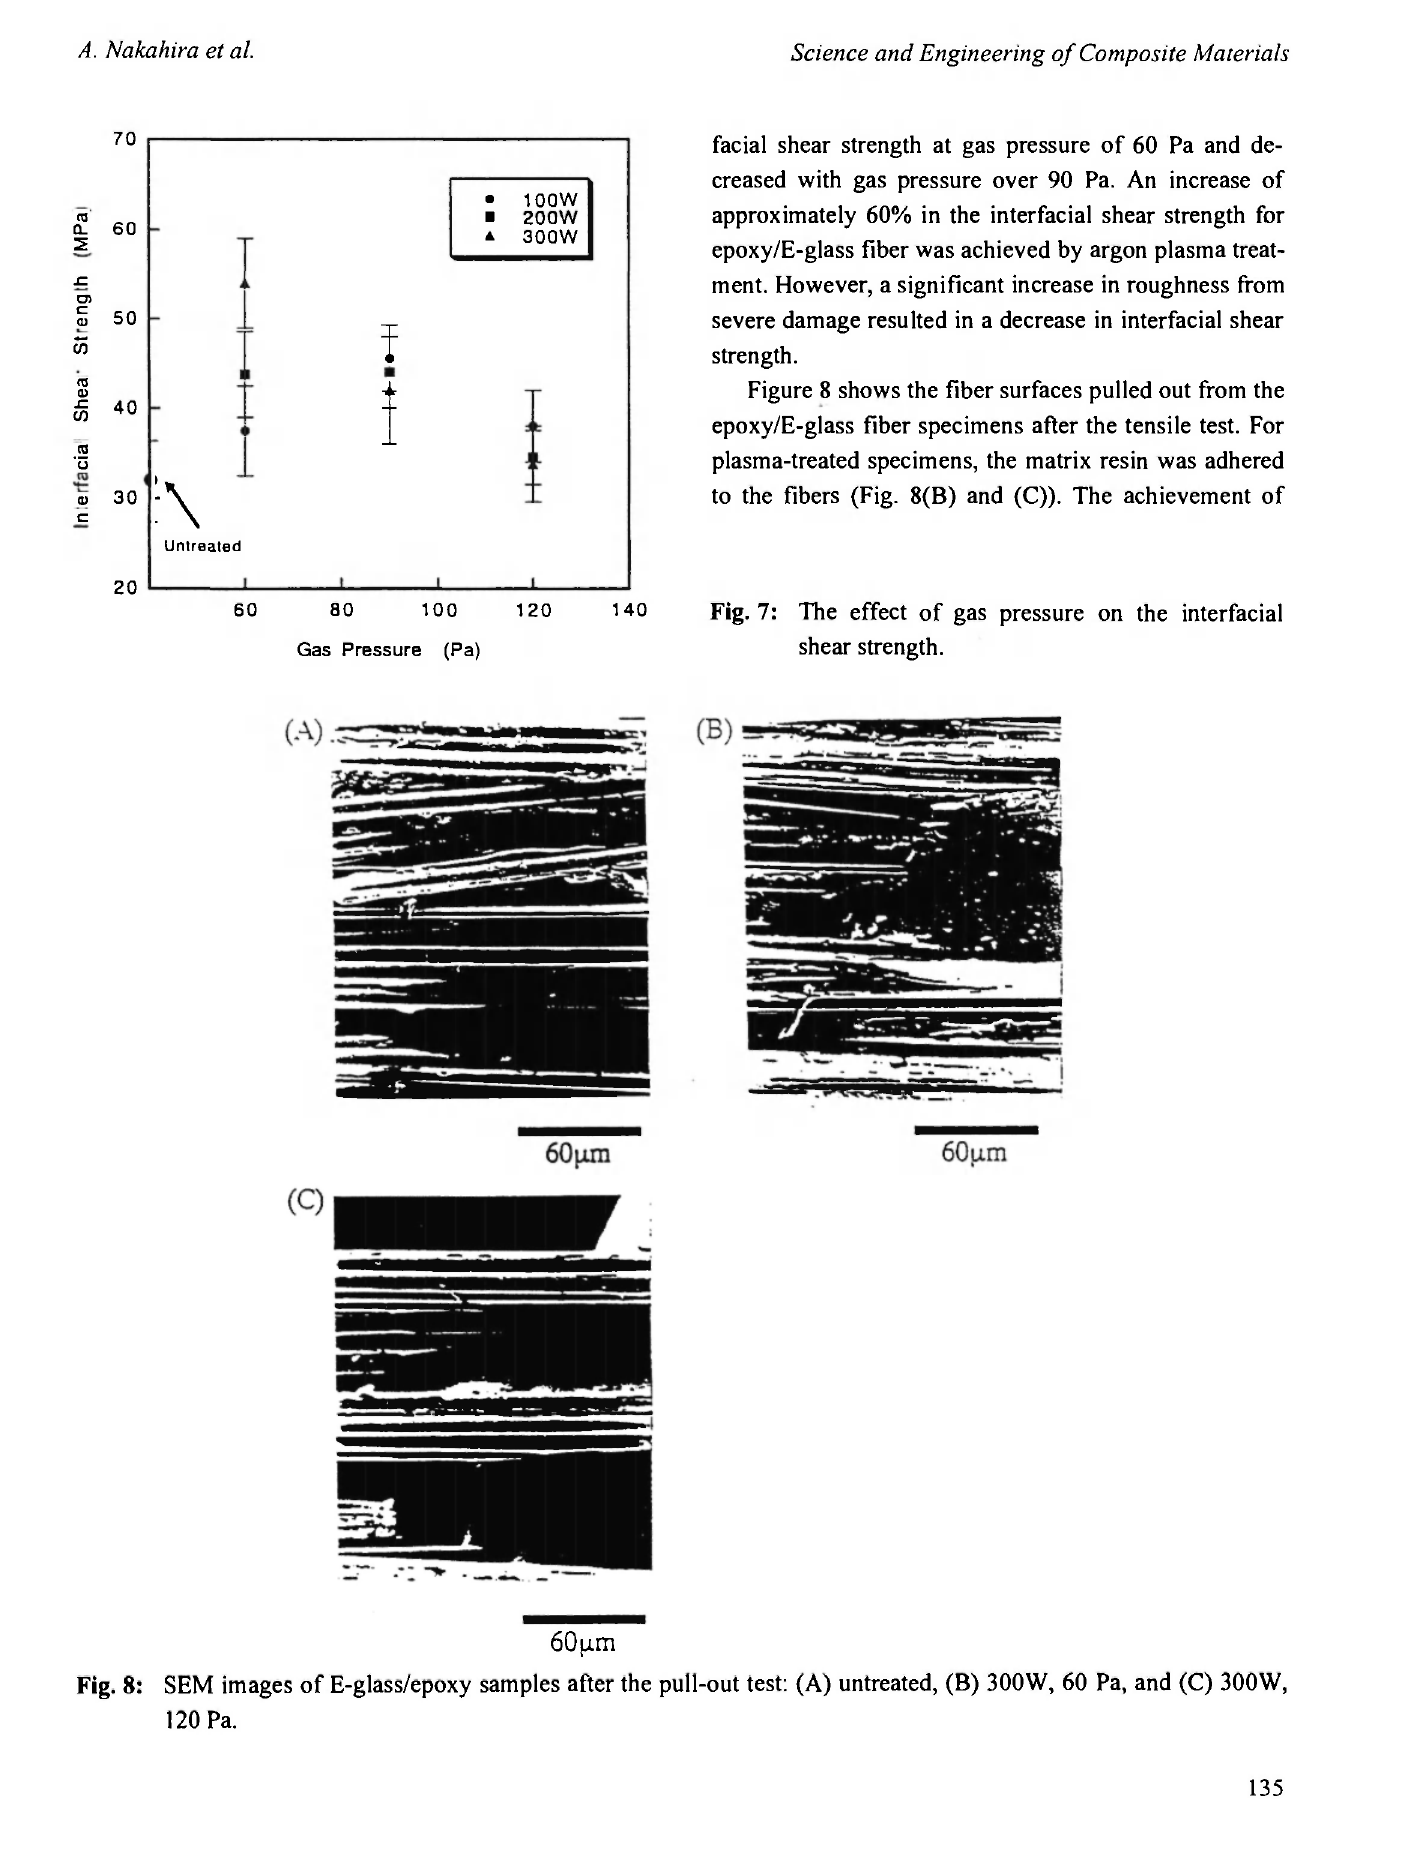
Fig. 8: SEM images of E-glass/epoxy samples after the pull-out test: (A) untreated, (B) 300W, 60 Pa, and (C) 300W, 120